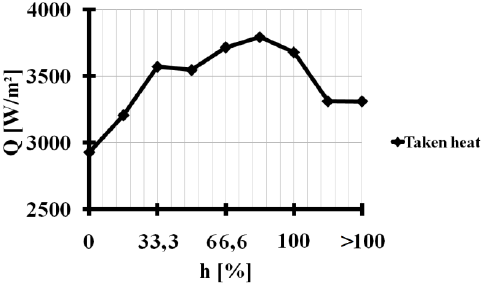
Figure 5. Heat flux delivered to the evaporator as a function of the percentage filling height, minigap 2 mm.